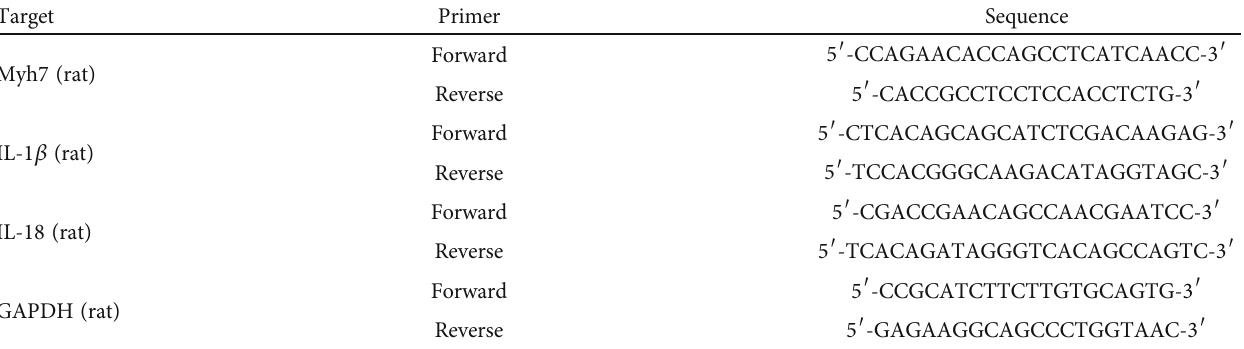
Table 1: Relative primer sequence used in real-time